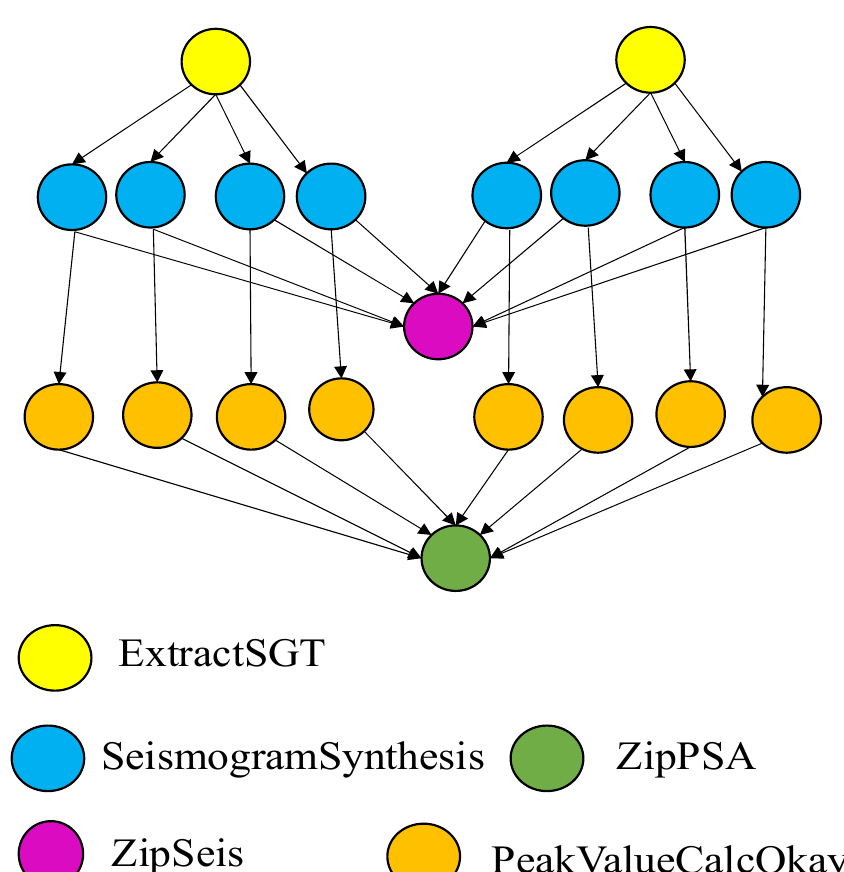
Figure 5. Epigenomics.